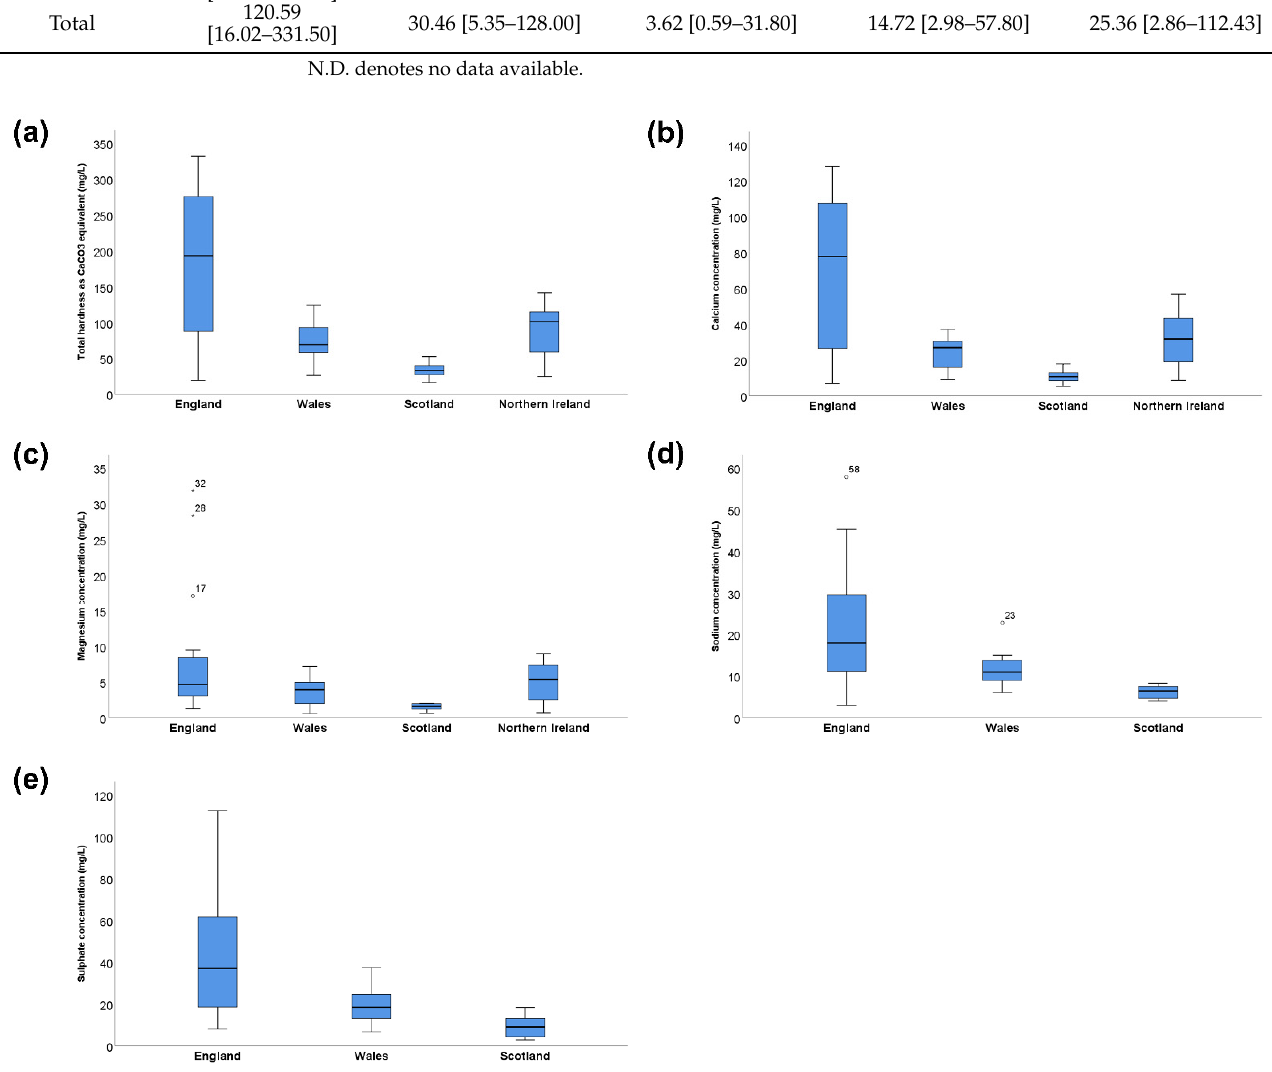
Figure 1. Distribution of the mineral composition of tap water across the United Kingdom. Mineral composition of tap water by country (mg/L). ( a ) Total water hardness as CaCO3 equivalent ( b ) Cal- cium concentration ( c ) Magnesium concentration ( d ) Sodium concentration ( e ) Sulphate concentration. ○ Outlier (value > 1.5 IQR); ★ Extreme outlier (value > 3 IQR ). N.D. denotes no data available.